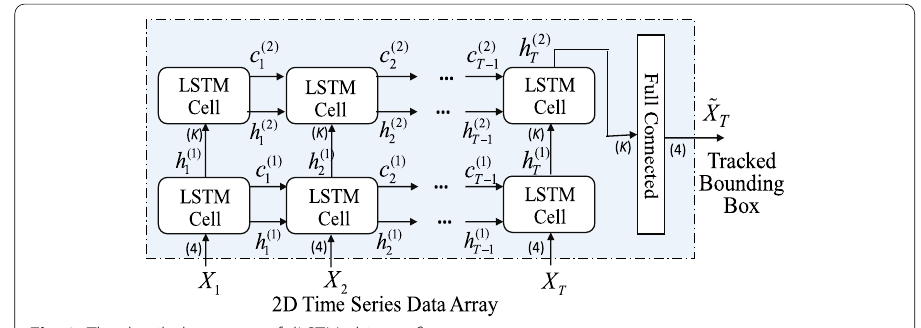
Fig. 8 The detailed structure of dLSTM object